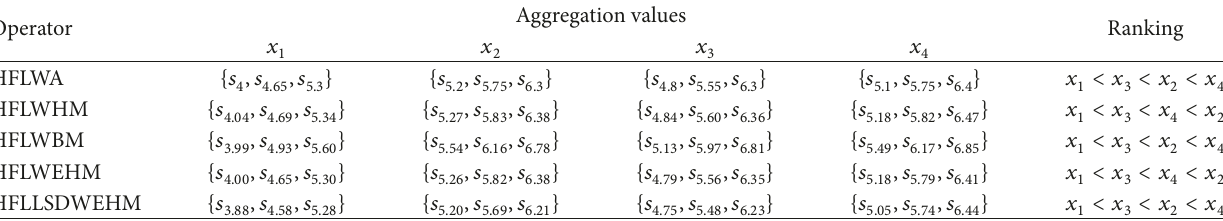
Table 10: Aggregation results by different operators (𝑝 = 𝑞 = 1) .